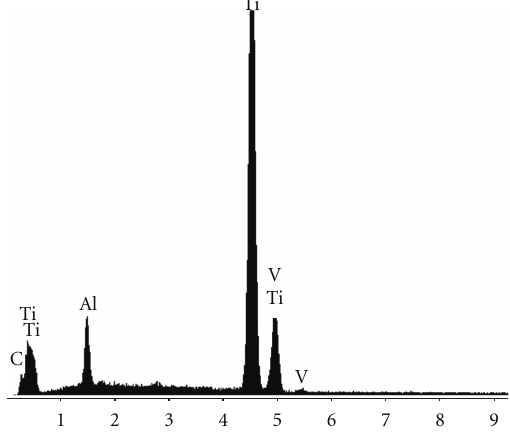
Figure 9: EDS microanalysis of the adhered material marked as1 in Figure 8.